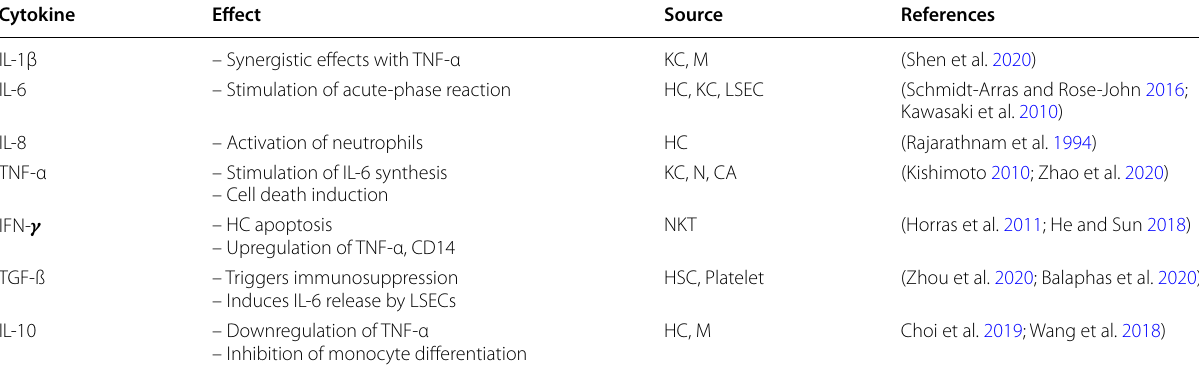
KC Kupffer cell, HC hepatocyte, N neutrophil granulocyte, CA cholangiocyte, NKT natural killer cell, LSEC liver sinusoidal endothelial cell, HSC hepatic stellate cell, M Macrophage